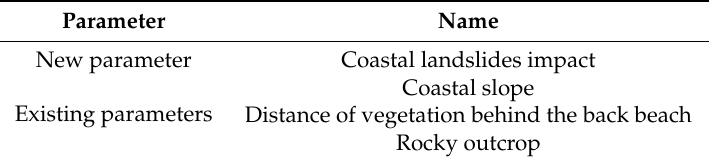
Table 1. New and existing parameters for coastal vulnerability evaluation.